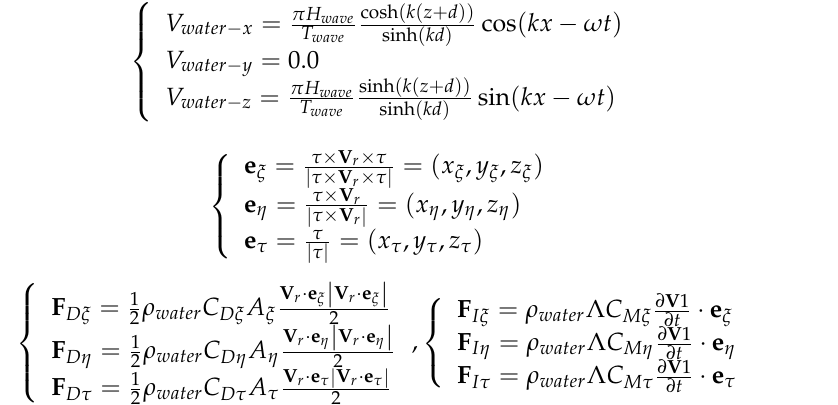
Figure 2. Calculation method of the floating structure and fishing net. ( a ) Floating frame’s structure number (Circular label, Square label, Triangle label). ( b ) Numbering method of fishing net and force on the node of fishing net.